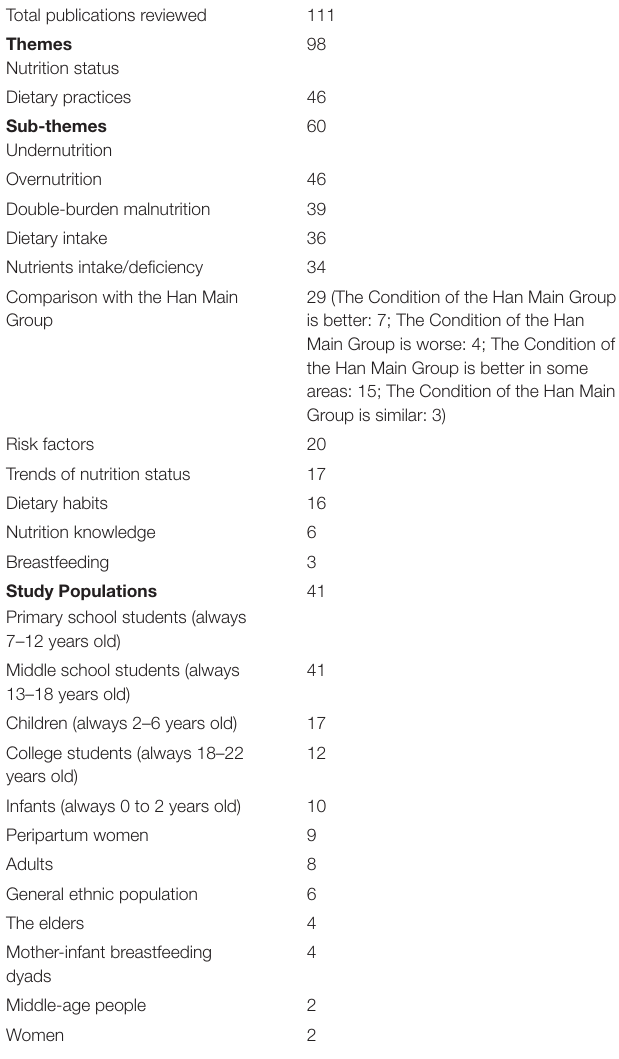
TABLE 1 | Information about publications, themes, sub-themes, and study